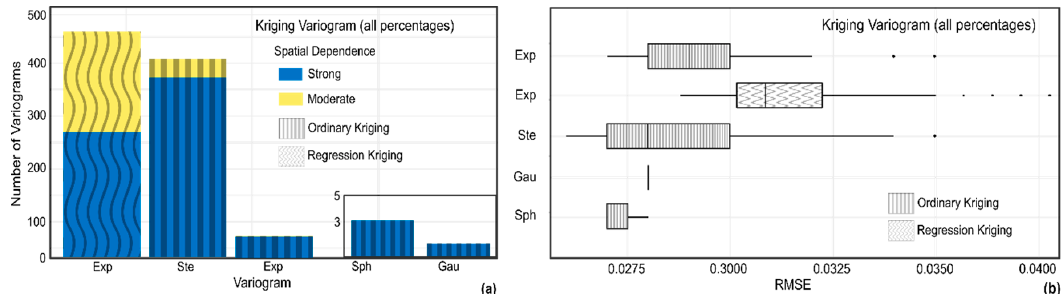
Figure 7. ( a ) Most fitted variogram models used to predict soil moisture; 459 models generated for both OK and RK in 153 monthly layers derived from all percentages (100%, 75%, and 50%) of valid pixels; ( b ) Boxplots of the RMSE for each predicted layer using the selected variograms.